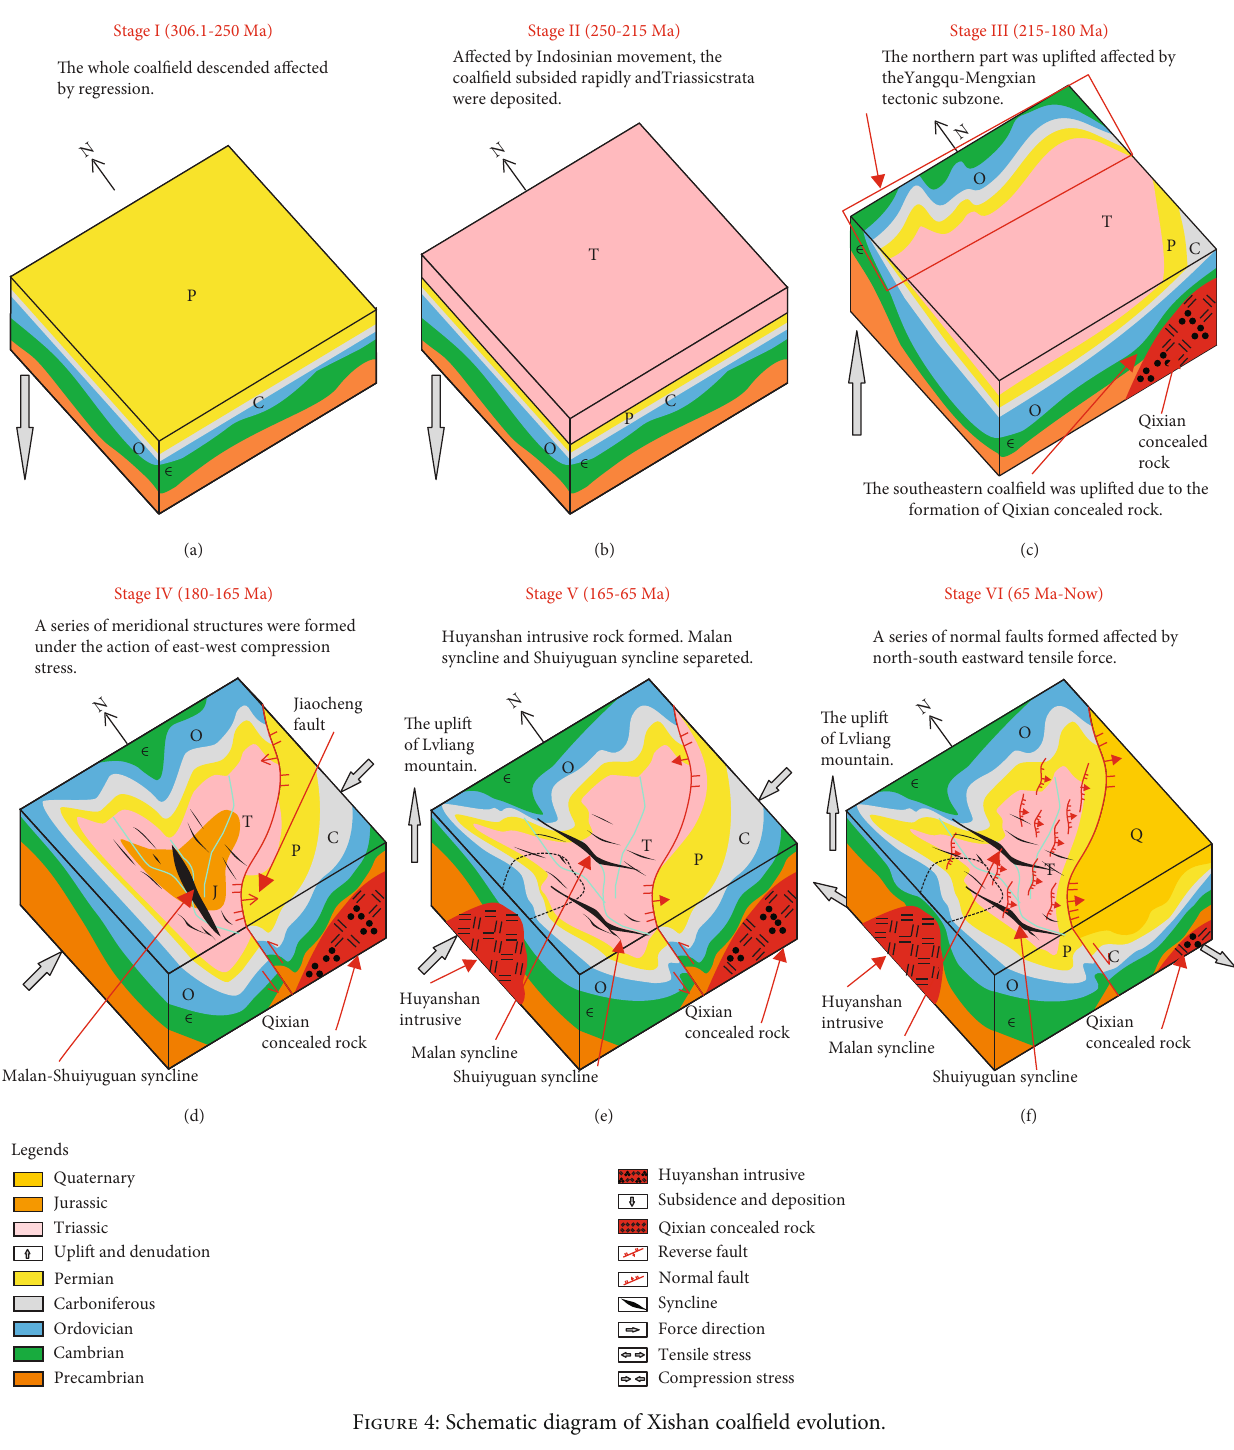
Figure 4: Schematic diagram of Xishan coal fi eld